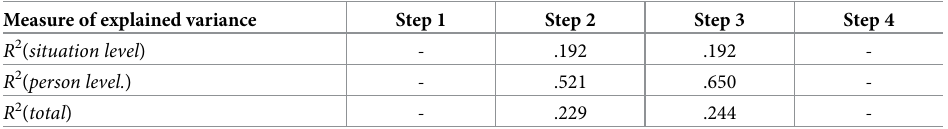
Table 8. Local and global estimates of explained variance at the two levels of the multilevel model. Measure of explained variance Step 1 Step 2 Step 3 Step 4 .192 .192 - - .521 .650 - - .229 .244 -